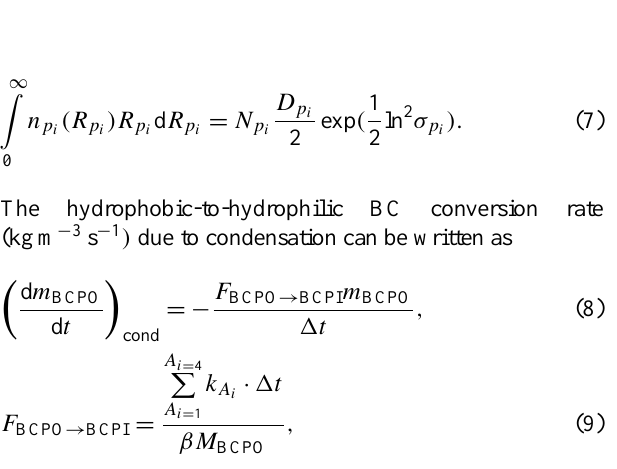
All hydrophilic particles D p increased by 50% All hydrophilic particles D p decreased by 50% SD PI + 0 . 2 All hydrophilic particles σ p increased by 0.2 SD PI − 0 . 2 All hydrophilic particles σ p decreased by 0.2 BETA2.5 MP chem from Pöschl et al.